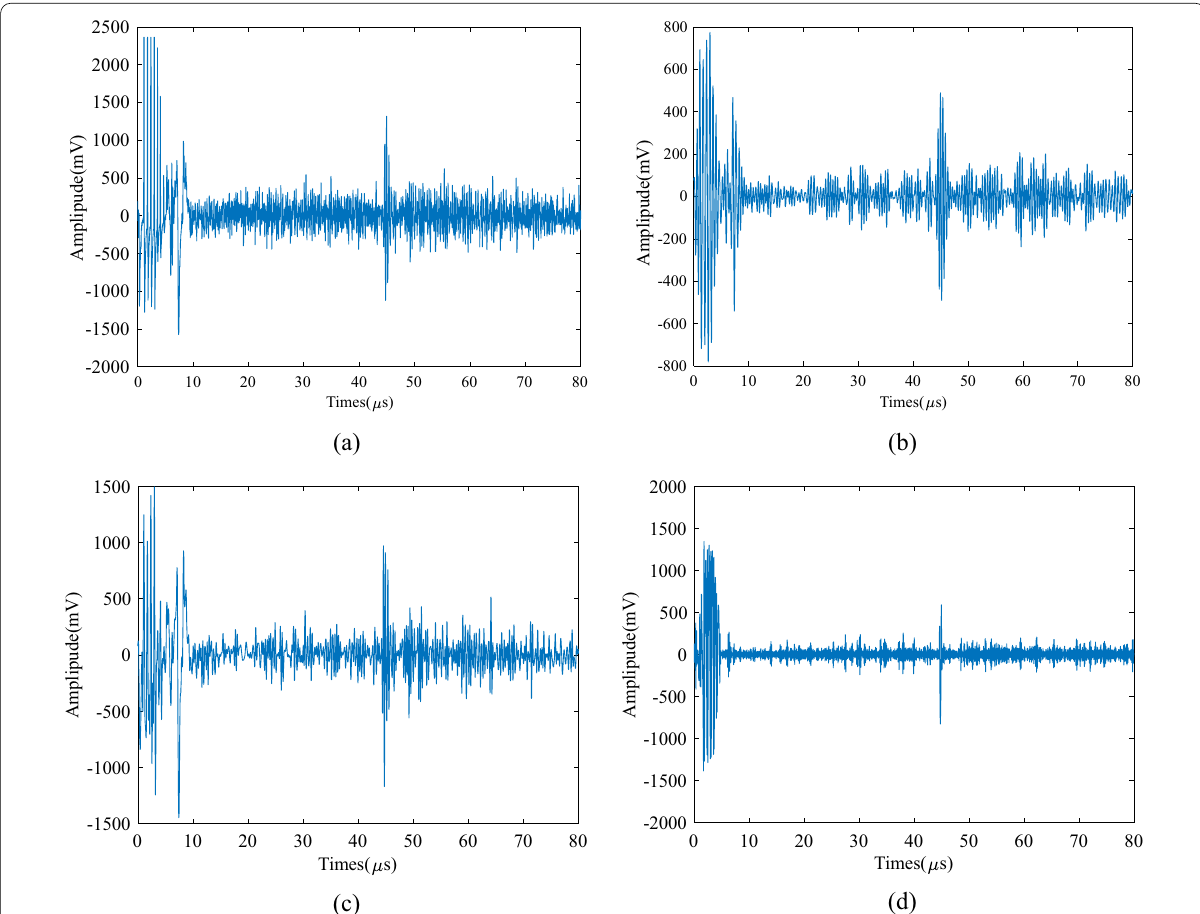
Figure 11 Ultrasonic signal of 12CrMo at 625 °C; ( a ) original signal, ( b ) VMD decomposition and reconstruction signal, ( c ) WT denoising signal, and ( d ) EMD denoising